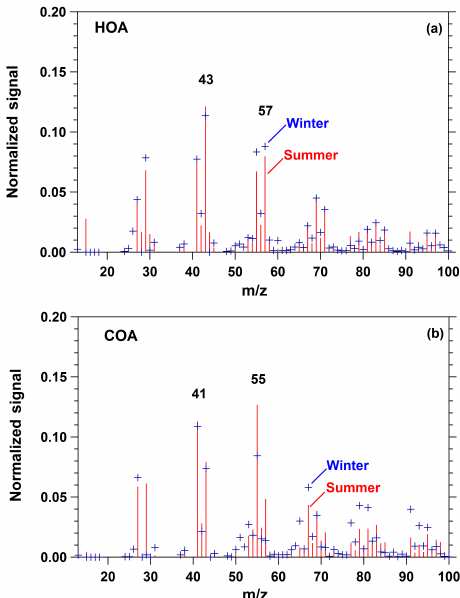
Figure 7. Seasonal mass spectra comparison for (a) HOA and (b) COA in Paris. Red lines correspond to the summer measure- ments while blue symbols correspond to the winter